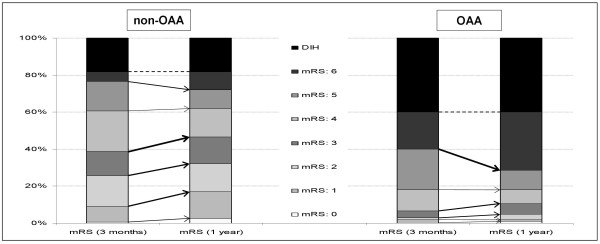
Dichotomized analysis of the mRS distribution at 90 days and 1 year for non-OAA and OAA patients. The dashed line indicates, within the mRS = 6 group, the proportion of patients who died in the hospital (DIH). The thickness of arrows indicates the proportional shift from short- to long-term outcome within the mRS groups.